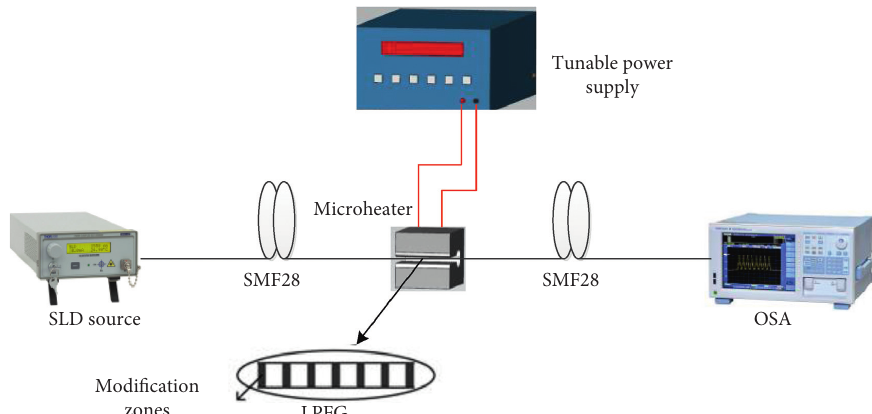
Figure 2: The surface morphologies of the fabricated LPFGs.